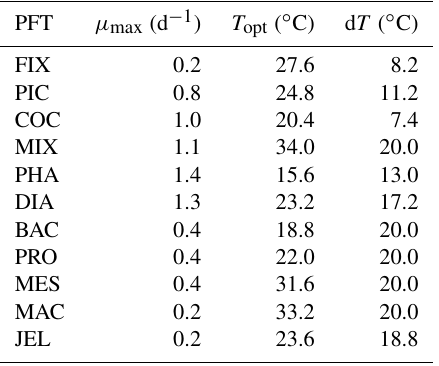
Table 2. Parameters used to calculate PFT-specific growth rate with a three-parameter fit (Eq. 3) in PlankTOM11.